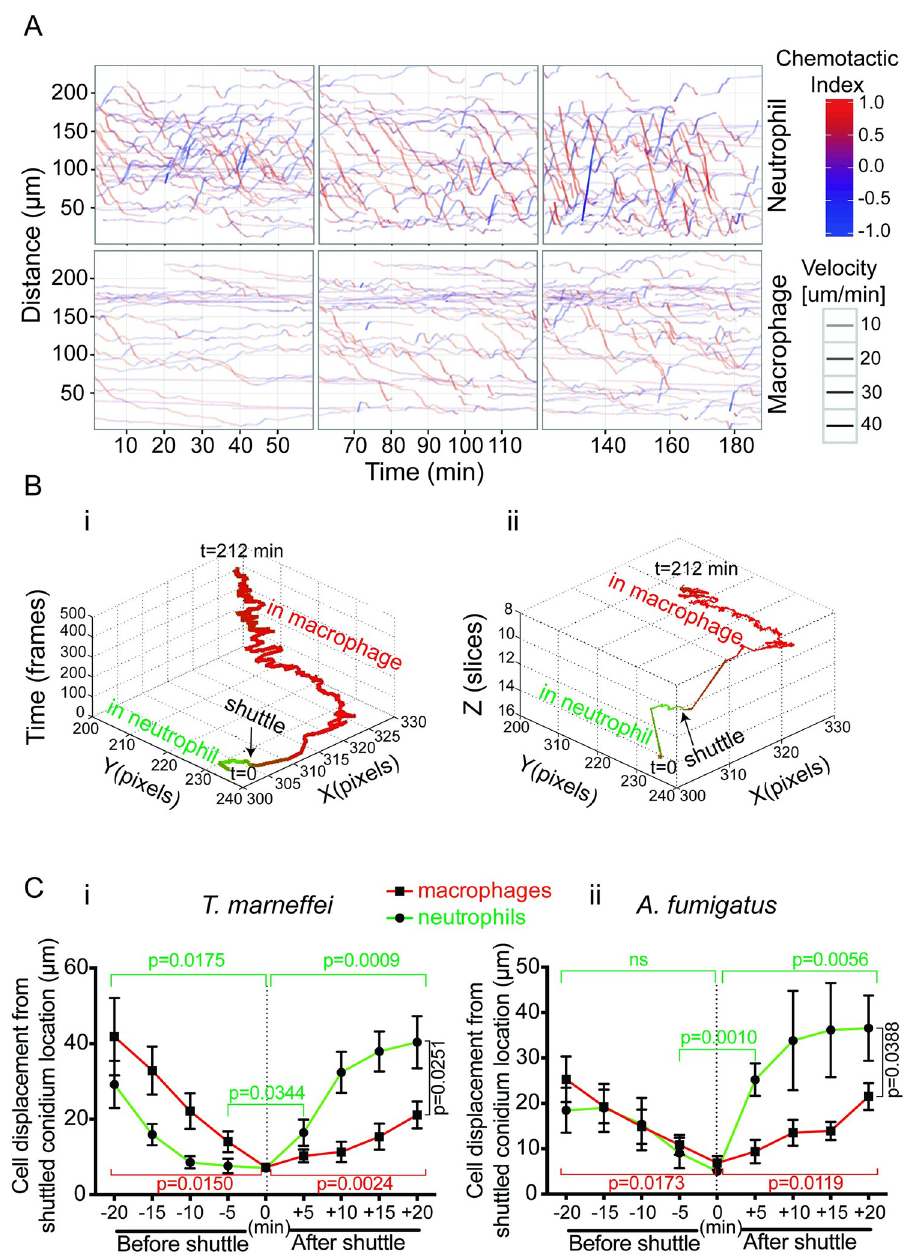
Fig 4. Phagocyte mobility during shuttling. (A) Cell tracking analysis of neutrophil and macrophage following intramuscular inoculation of T . marneffei conidia. A chemotactic index (red, movement towards infection; blue, movement away) and velocity (thickness of the line). Neutrophil migration towards the infection is earlier and faster; macrophage migration is later and slower. (B) Output of ShuttleFinder software for the shuttle shown in Fig 1A. Track color indicates the cellular context of the conidium (green, neutrophil; red, macrophage). (i) shows the shuttled spore track in xy dimensions and time. (ii) shows it in xyz dimensions. The two outputs collectively show that the shuttle occurred between donor and recipient phagocytes that were mobile in both space and time. Imaging parameters: x , y , 1.31 pixels/ μ m; z interval, 3.3 μ m/slice; frame rate, 28.0 s/frame. (C) Plots of donor neutrophil and recipient macrophage cell displacement from the shuttle spore location over the 20-min period before and after the moment of shuttle for T . marneffei (i) and A . fumigatus (ii) shuttles. Note that displacement is a measured distance without directional information. Data are mean ± SEM at each time point (i, n = 10; ii, n = 7). P -values from two-tailed paired t tests (all +20 and -20 min vs 0 comparisons), otherwise from one-tailed paired t tests. Datasets for C are provided in S1 Data. ns, not